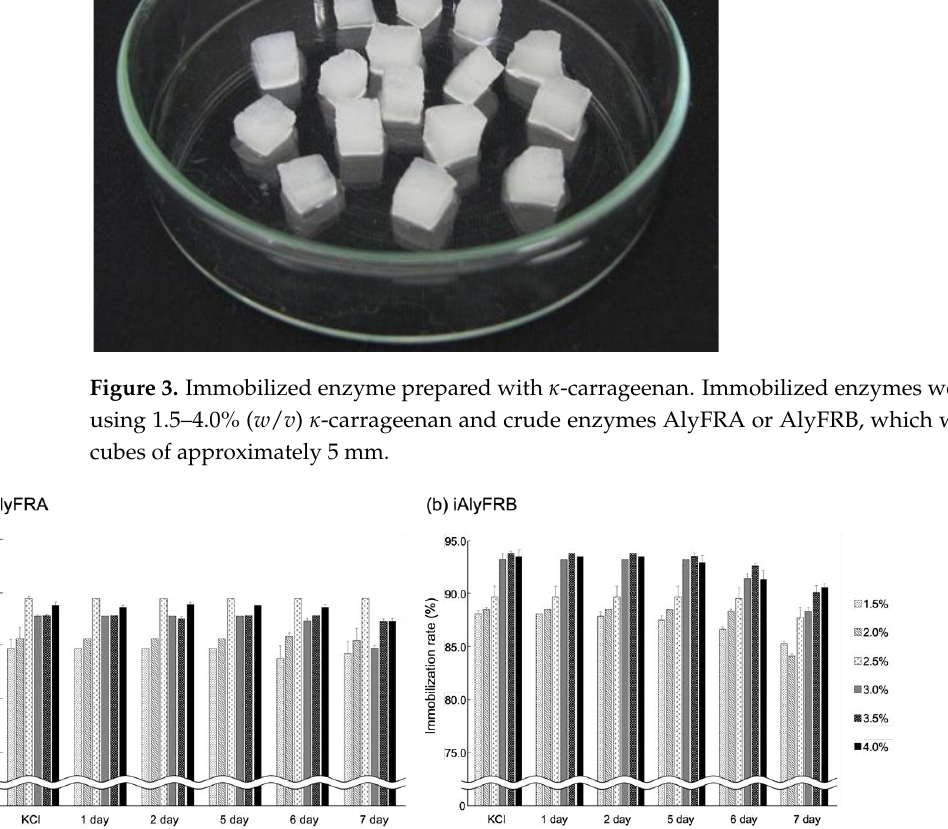
Figure 4. Immobilization rate of iAlyFRA ( a ) and iAlyFRB ( b ). iAlyFRA and iAlyFRB were prepared with 1.5–4.0% ( w / v ) κ -carrageenan soaked in 100 mL of 20 mM phosphate buffer (pH 7.4) containing 100 mM NaCl at 20 ◦ C for 7 d. Each data point represents the average of the three independent experiments performed. Error bars show standard deviations ( n =